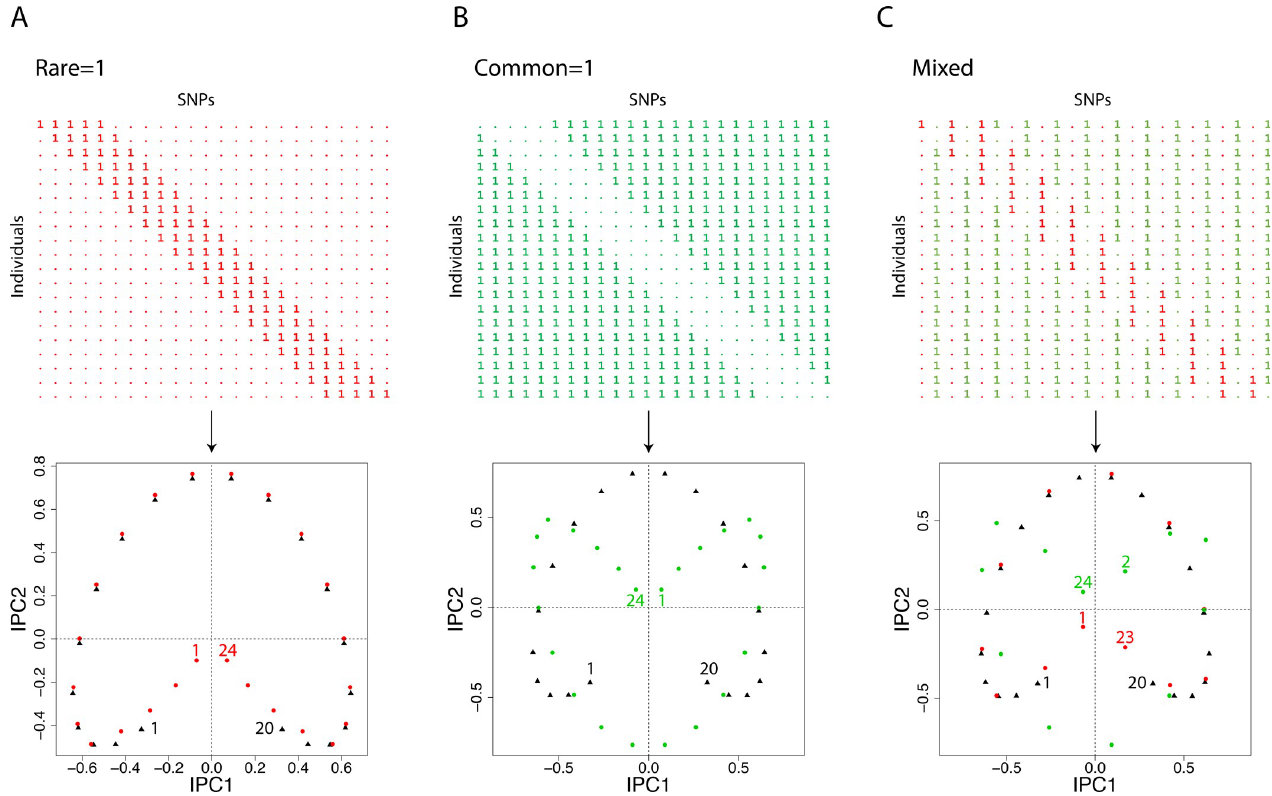
Fig 4. A simple matrix and its DC-PCA biplot, using three SNP codings. The matrix has 20 Individuals in its rows and 24 SNPs in its columns, with SNPs (columns) colored either red for SNP coding rare = 1, or green for common = 1. The biplots show the 20 Individuals as black triangles, and the 24 SNPs as dots colored either red for rare = 1, or green for common = 1. Selected points in the biplots are identified: Individuals are numbered 1 to 20 from top to bottom in the data matrix, and SNPs 1 to 24 from left to right. (A) For SNP coding rare = 1, despite the arch distortion in the biplot, related Individuals and SNPs track each other in a clear and intuitive manner. (B) For SNP coding common = 1, the arch for SNPs is rotated 180˚ relative to the arch for Individuals, which is confusing. (C) For SNP coding mixed, those SNPs with coding rare = 1 (red dots) track the Individuals (black triangles), whereas those SNPs with coding common = 1 (green dots) are rotated 180˚ relative to the other two arches. Taken together without distinguishing red from green, the dots for the SNPs approximate a circle rather than an arch, so awareness of the arch distortion would not suffice to interpret this very confusing biplot